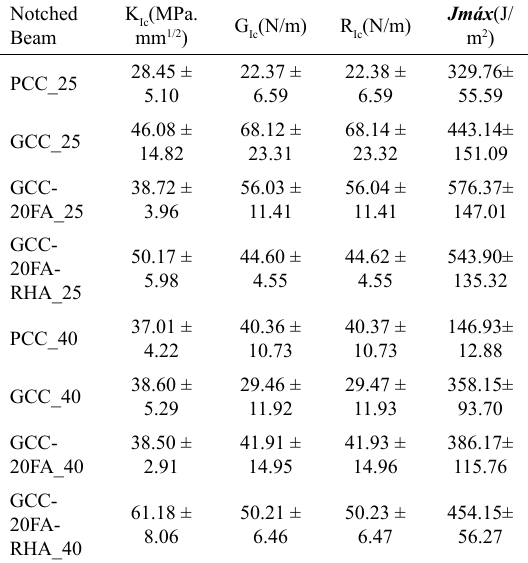
Table 2. Average values of fracture